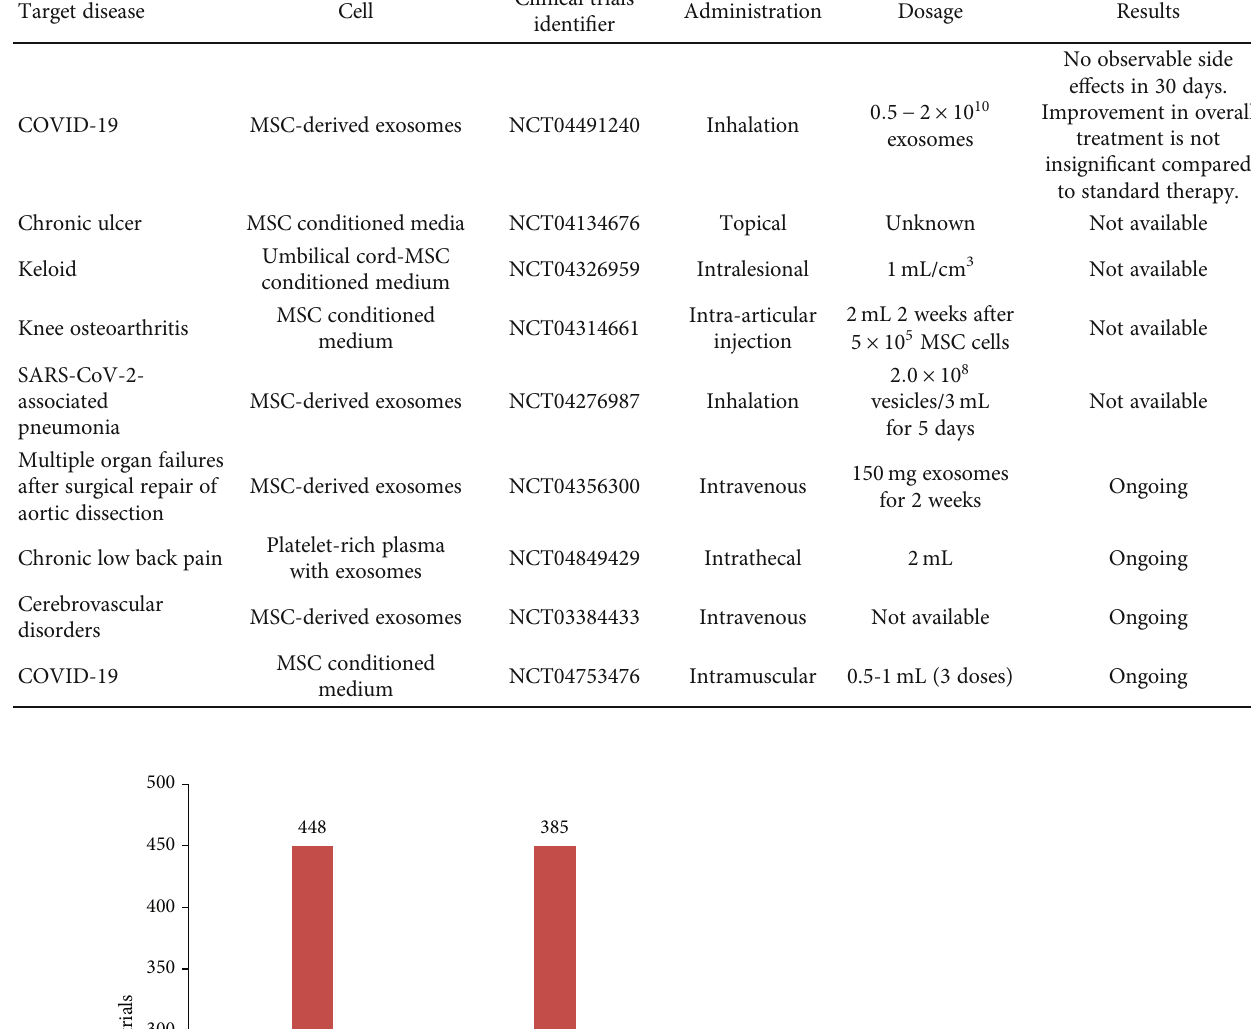
Table 3: Cell-free treatment in clinical trials for various